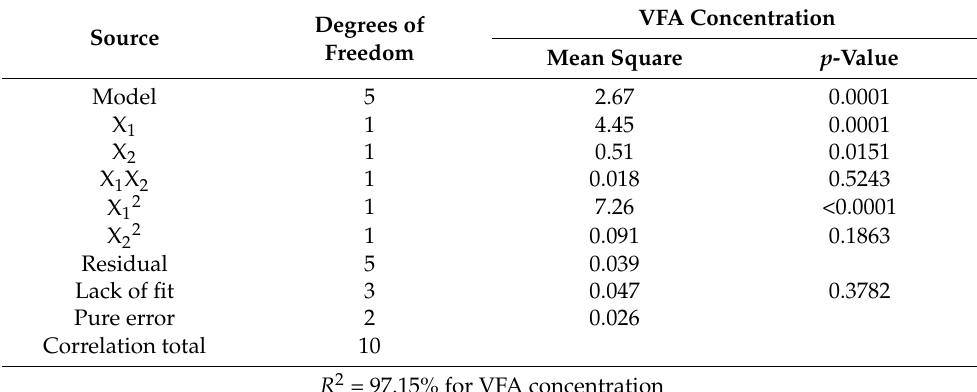
Table 2. Analysis of variance of the experimental VFA concentration data. Degrees Source